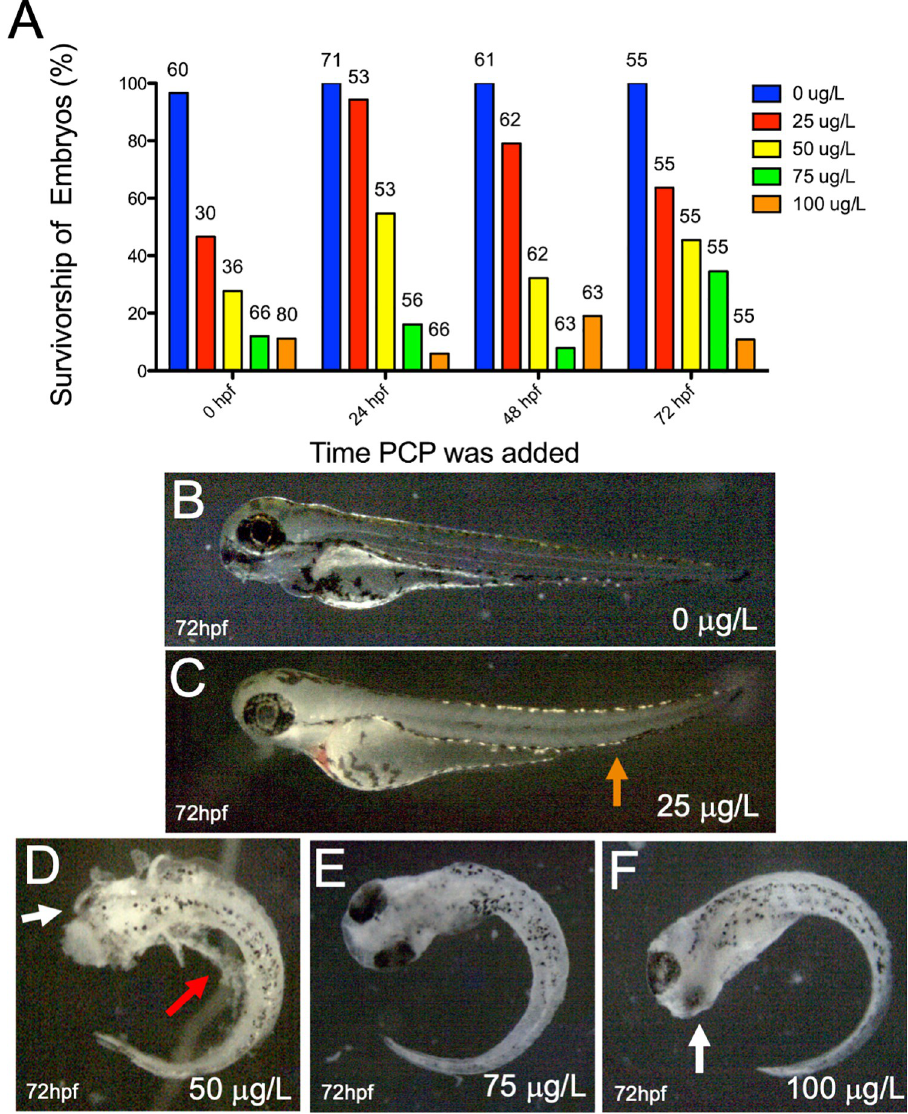
Fig 1. Survivorship of zebrafish embryos decreased and malformations increased across all treatment time periods as PCP concentrations increased. A) PCP was added to zebrafish embryos at 4 distinct time points: 0, 24, 48, and 72 hpf. PCP was administered at concentrations of 0 (blue), 25 (red), 50 (yellow), 75 (green), and 100 (orange) μ g/ L. All embryos were analyzed 24 hours after PCP administration. Numbers above bars represent how many embryos were analyzed for that condition. B) Example of a 72 hpf zebrafish treated with 0 μ g/L PCP at 48 hpf. C) Example of a 72 hpf zebrafish treated with 25 μ g/L PCP at 48 hpf. Orange arrow denotes abnormal tail curvature. D) Example of a 72 hpf zebrafish treated with 50 μ g/L PCP at 48 hpf, with eye malformation (white arrow) and necrotic tissue (red arrow). E) Example of a 72 hpf zebrafish treated with 75 μ g/L PCP at 48 hpf that had body axis curvature. F) Example of a 72 hpf zebrafish treated with 100 μ g/L PCP at 48 hpf that had body axis curvature and eye malformations (white arrow). expression of a green fluorescent protein. mpx :GFP mainly marks neutrophils, which are the most abundant leukocytes in the animal that protects it from bacterial infection. Again, we uti- lized only live fish for these analyses; fish that were obviously necrotic, severely morphologi- cally defective, lacking a heartbeat or normal physiological response to stimuli were excluded from these studies. To live fish, we administered PCP to embryos at 0, 24, 48, and 72 hpf.